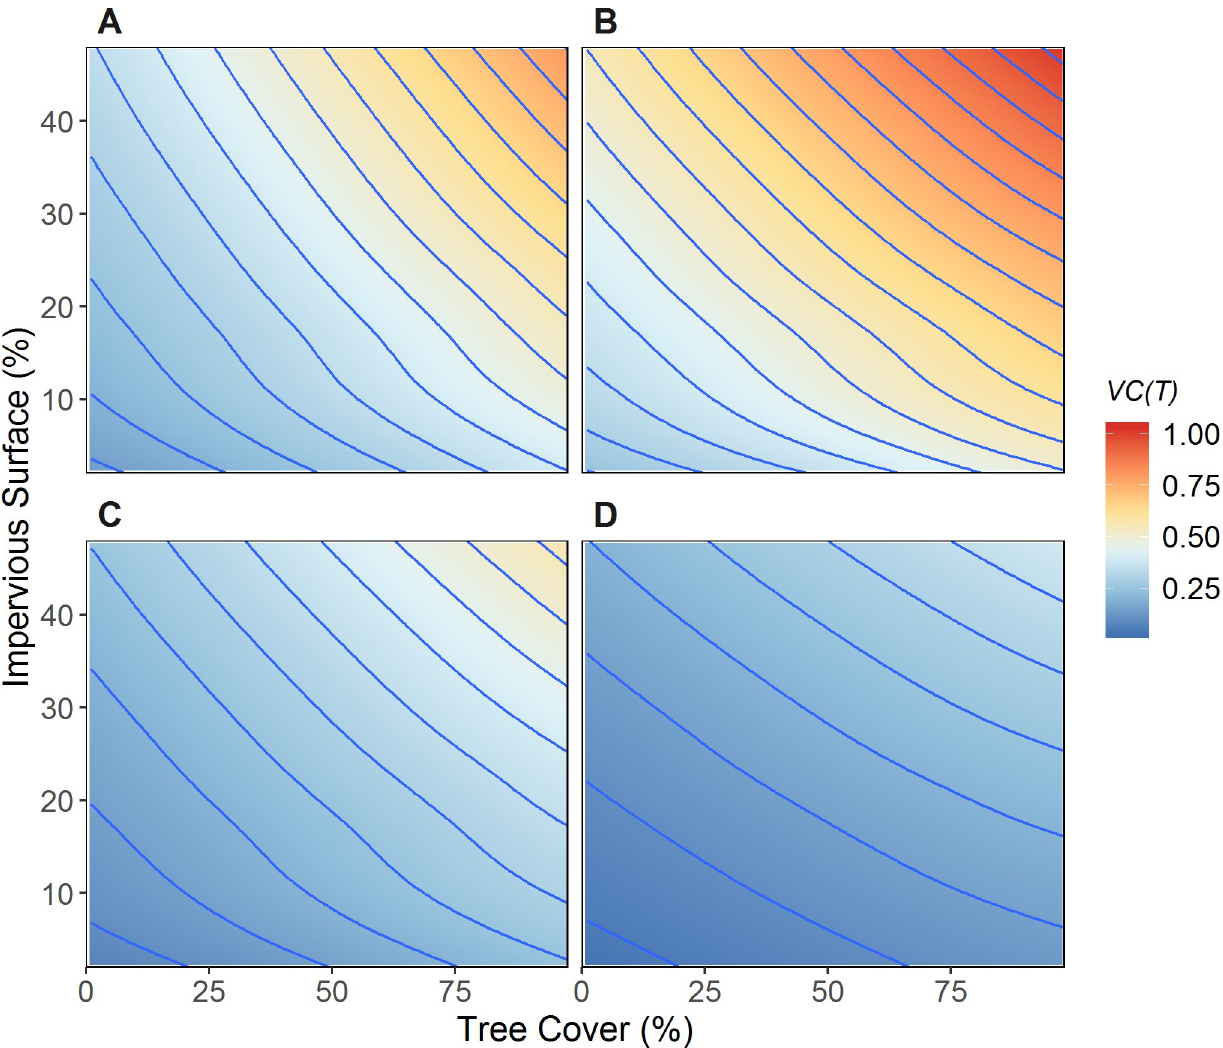
Fig 8. Contour plots of temperature-dependent vectorial capacity ( VC(T) ) in relation to percent tree cover (summarized locally in a 30 m grid cell) and percent impervious surface (summarized within a 1-km circular window). The response surface was generated using LOESS (localed